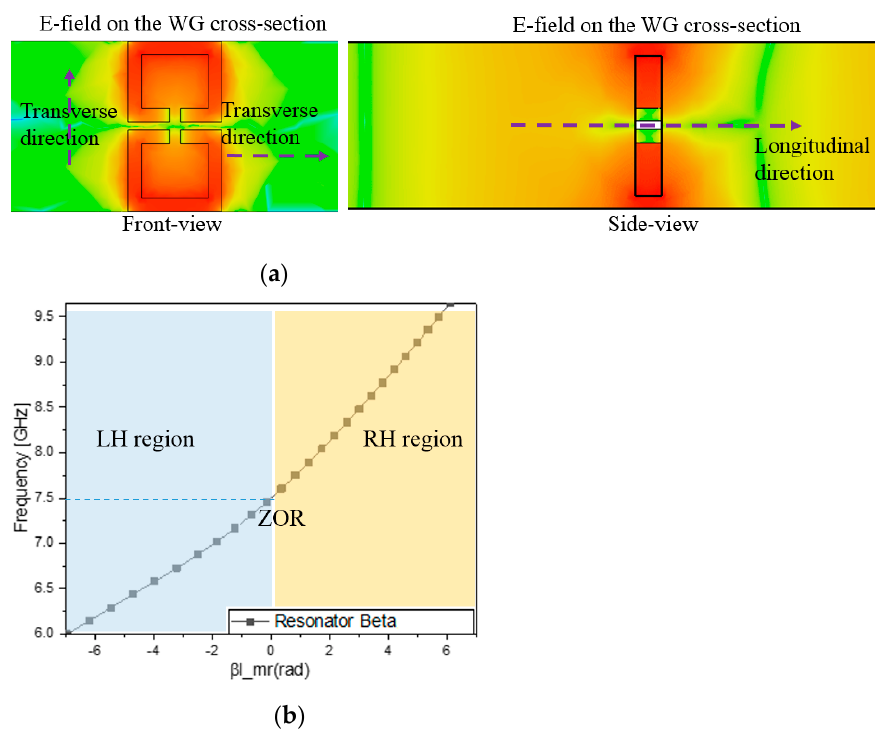
Figure 4. Observing the ZOR of the resonator: ( a ) E-field resonant and confined in a thin plane ( b ) dispersion diagram.